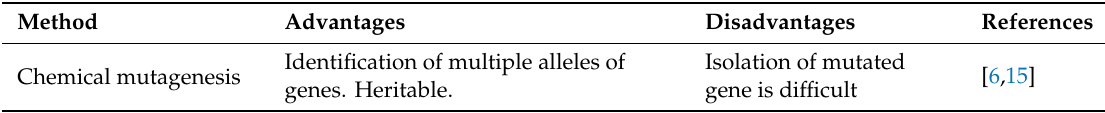
Table 1. Advantages and disadvantages of di ff erent mutagenic